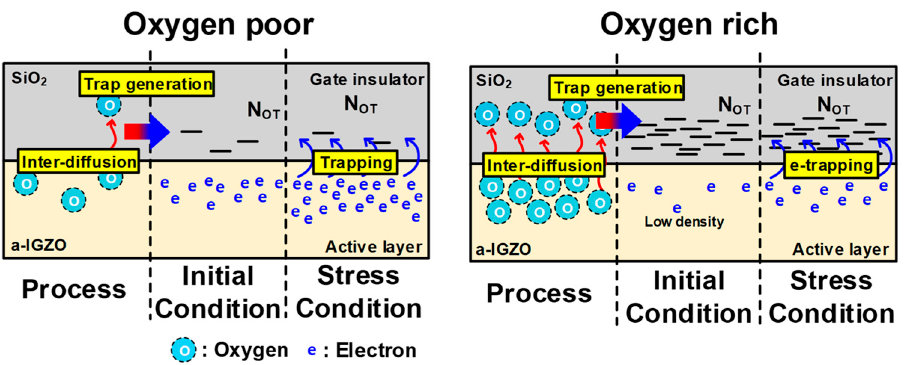
Figure 7. Production of electron trap centers according to O-content.